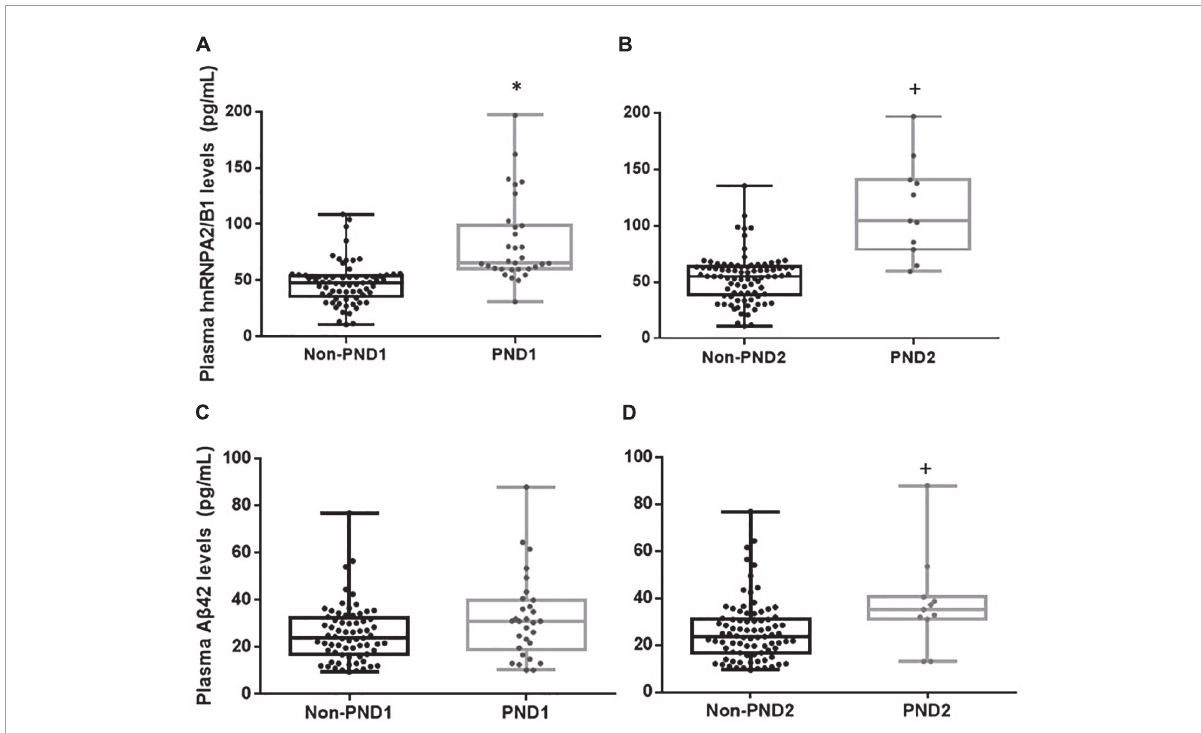
FIGURE3 Plasma hnRNPA2/B1, A β 42 . Concentrations of hnRNPA2/B1 or A β 42 in patients with or without PND at 7 days (A,C) and 3 months (B,D) after surgery. Boxes represent the median, the 25th and 75th percentiles, and bars indicate the range of data distribution. ∗ p < 0.05 compared with group Non-PND 1 . + p < 0.05 compared with group Non-PND 2